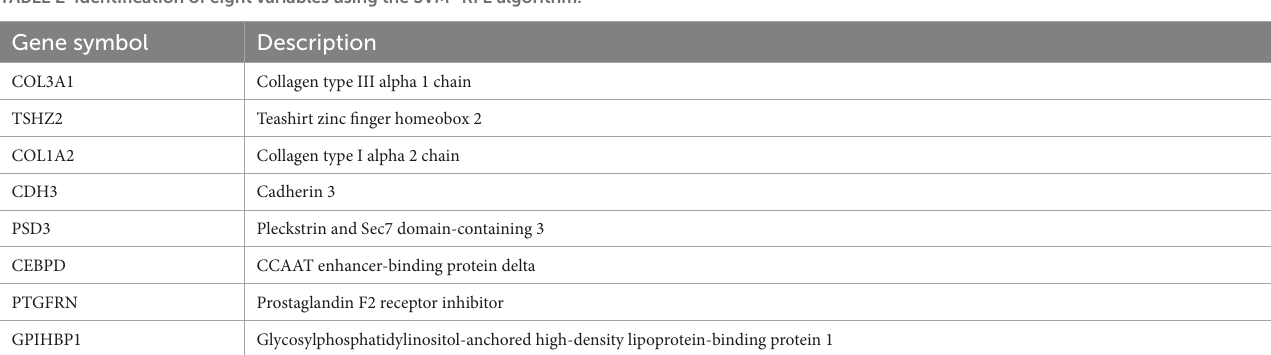
TABLE 2 Identification of eight variables using the SVM–RFE algorithm. Gene